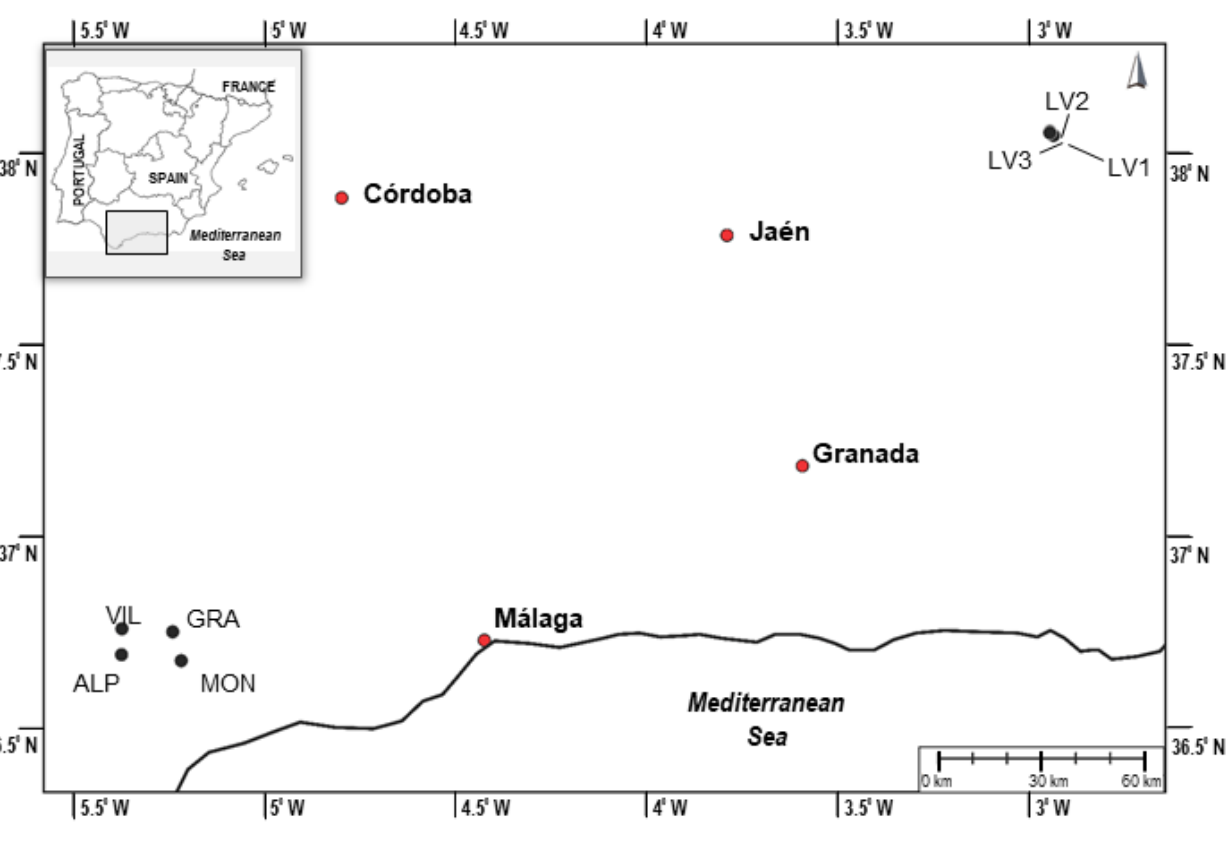
Figure 3. Geographic locations of the sampling sites of C. reverchonii species in Andalusia